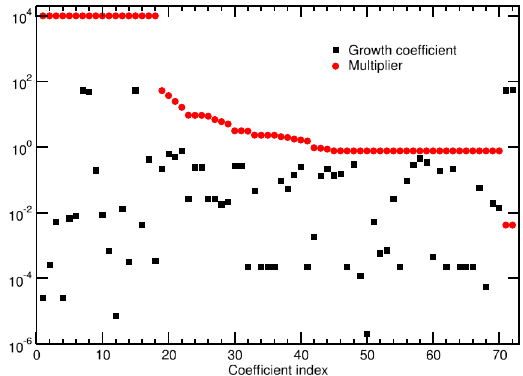
Figure 2. Plot of multipliers and growth coefficients. The largest permissible multiplier σ (red) sorted in descending order for each of the 72 growth coefficients in E . coli model iJO1366 25 . The absolute value of the stoichiometric growth coefficient is shown for comparison (black). Note that the multiplier values for 18 indices (see Table 2 for names) have an undetermined maximal value > 10 26 and are placed at the vertical axis (10 4 ) for completeness.